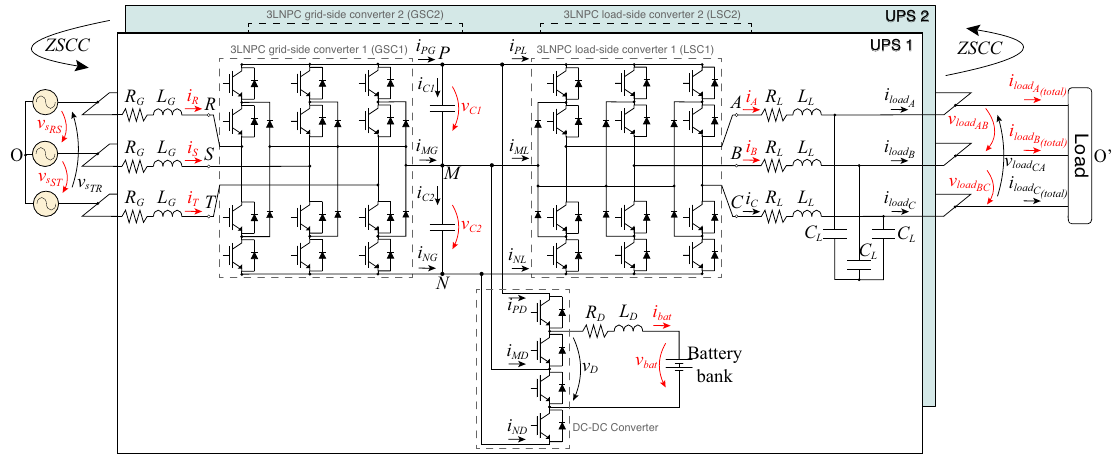
Figure 2. Circuit diagram of the proposed paralleled system.